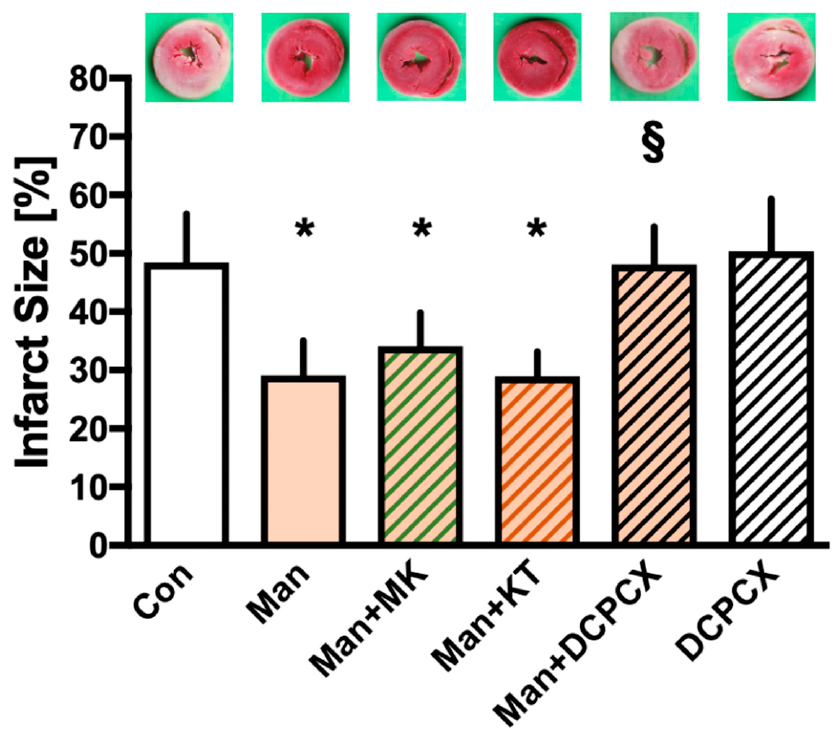
Figure 1. Infarct size measurement. Data are presented as means ± SD, Con = control; Man = Mannitol; MK = MK2206 (Akt inhibitor); KT = KT5823 (PKG inhibitor); DPCPX = adenosine receptor 1 antagonist. * p < 0.05 vs. Con, § p < 0.05 vs. Man.